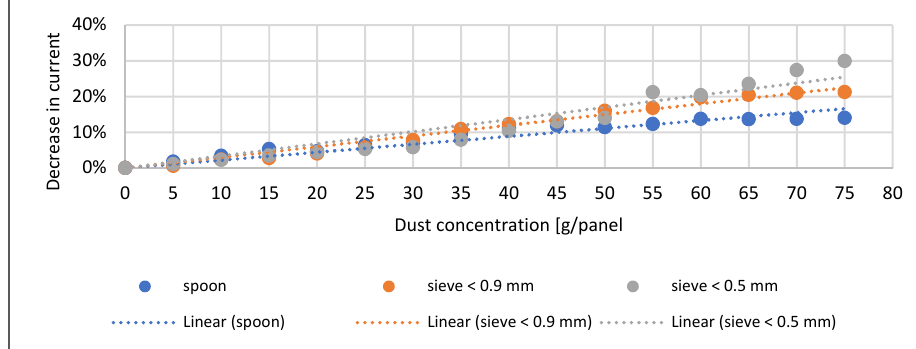
Figure 8. The short ‐ circuit current values as a function of the sand concentration.